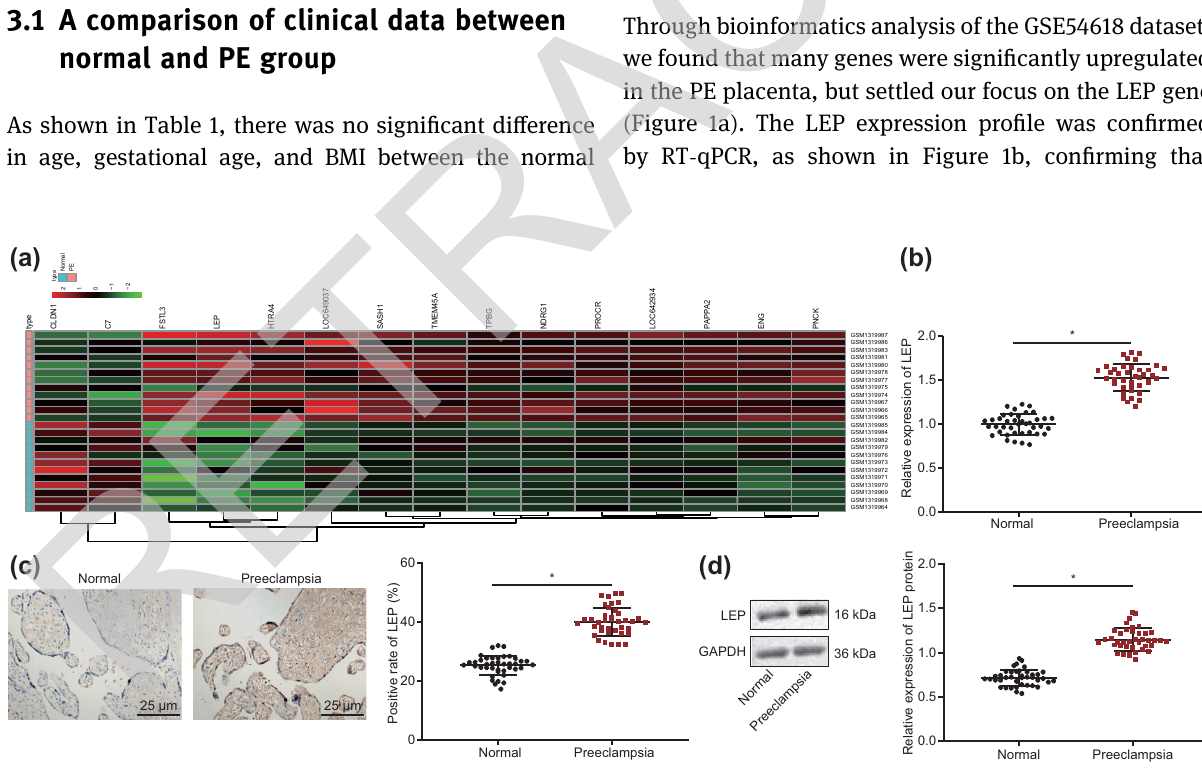
Figure 1: LEP is highly expressed in PE placenta. ( a ) Di ff erential gene expression heat map of the PE dataset GSE54618; the horizontal axis represents sample number, the vertical axis represents di ff erentially expressed genes, the histogram at the upper right depicts the color step, and each rectangle in the fi gure corresponds to a sample expression value. ( b ) The levels of LEP in normal pregnancy tissue and PE placenta tissue were tested with RT - qPCR ( Normal = 40; PE = 40 ) . ( c ) Immunohistochemistry was used to detect LEP positive cells ( 400 ×) in normal pregnancy tissue and PE placenta tissue ( Normal = 40; PE = 40 ) . ( d ) LEP protein levels were detected by Western blot in normal pregnancy tissue and PE placenta tissue; * indicates compared with normal group, P < 0.5 ( the result was measurement data, expressed as mean ± standard deviation, and unpaired t - test was used for two sets of data statistics result comparison )